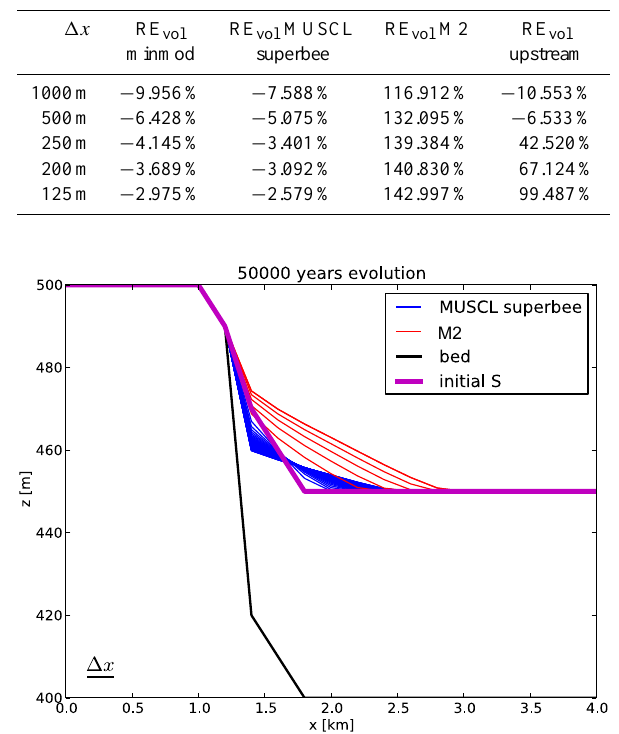
Fig. 4. Comparison of the “MUSCL superbee” (blue lines), with a classical “M2” scheme (red lines) for the mass conservation prob- lem described in Sect. 3. The initial surface is displayed as a ma- genta line. For both numerical schemes, solutions are plotted at 1000yr intervals for a 50000yr